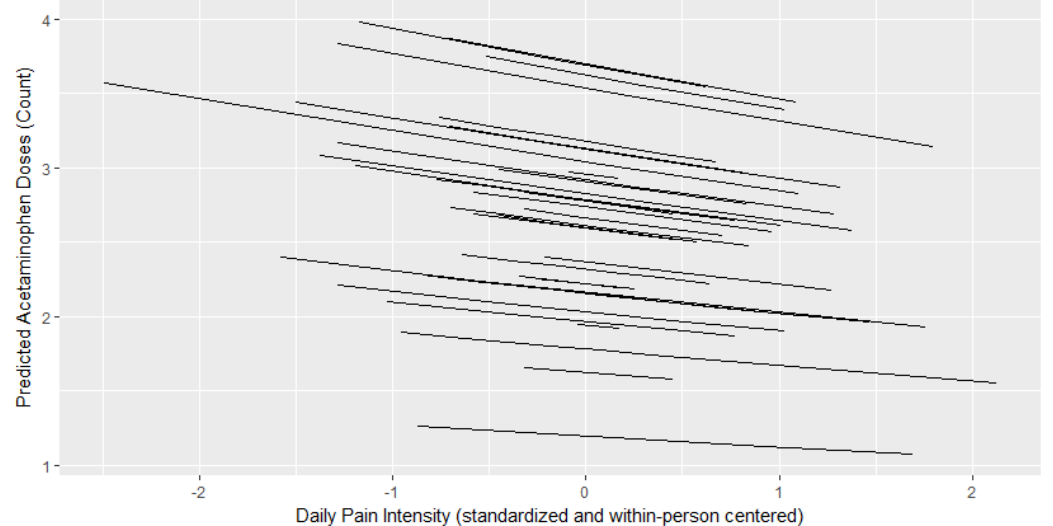
Figure 2. Within-person relationship between a child’s daily pain intensity and predicted acetaminophen doses administered. Daily pain intensity is within-person centered where a higher score indicates greater pain intensity on a given day compared to a child’s average across the postoperative period.